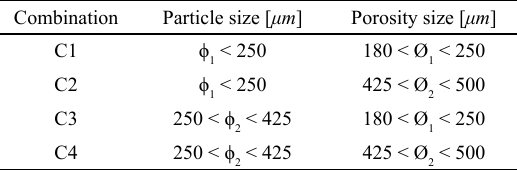
Table 2. Classification based on particle size and porosity.